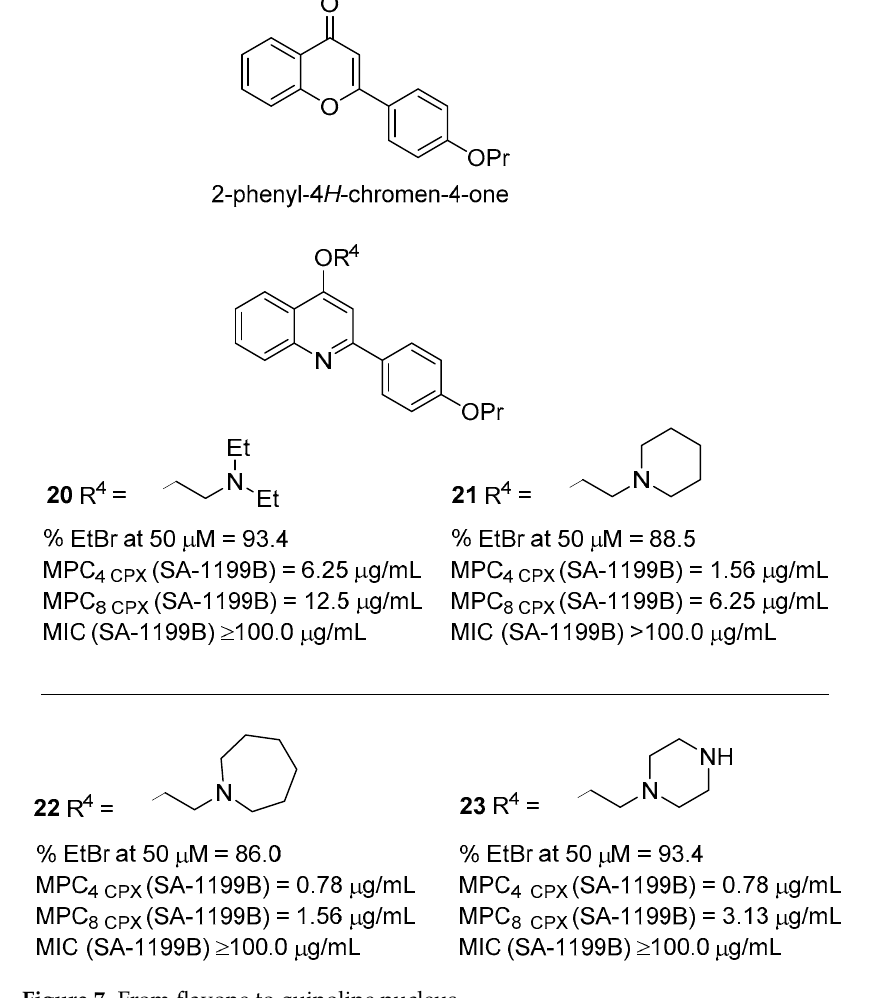
Figure 7. From flavone to quinoline nucleus.